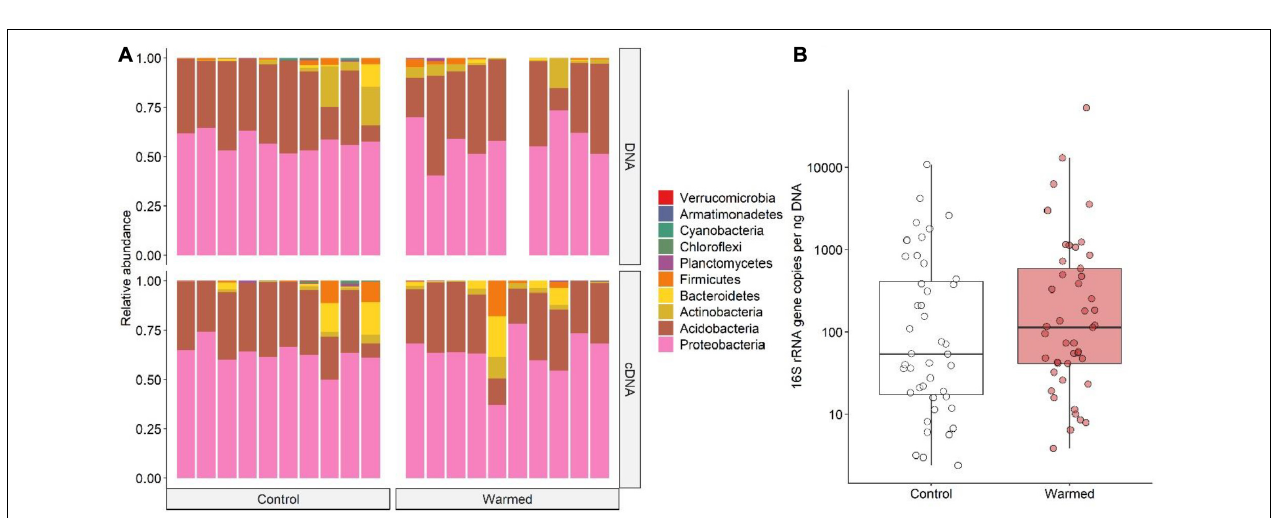
FIGURE 2 | Principal coordinate analysis of Bray-Curtis distances of the (A) DNA-based community composition and (B) cDNA-based community composition of the lichen C. islandica . Warmed samples are represented as black circles and control samples as gray circles. N = 28, n = 21 for DNA control, n = 17 for DNA warmed, n = 23 for cDNA control and n = 21 for cDNA warmed.